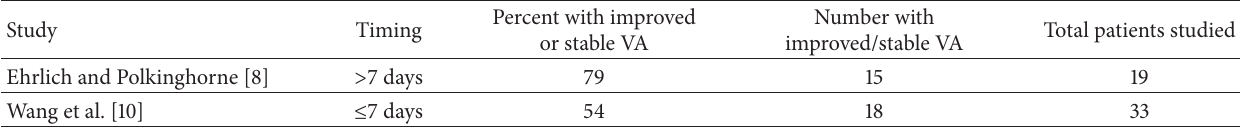
Table 4: Time to intervention versus percent with improved or stable visual